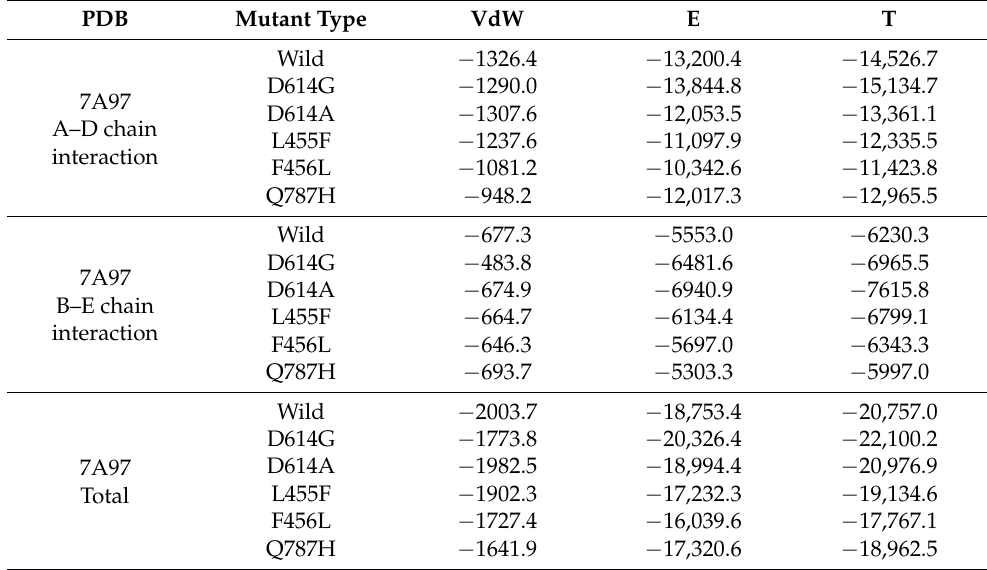
Table 3. Summary of MM/PBSA between the S protein and ACE2 in the 2-open-complex form. VdW indicates van der Waals energy, E denotes electrostatic energy, and T is total energy (kJ/mol). The values were measured in the final trajectory (10 ns).